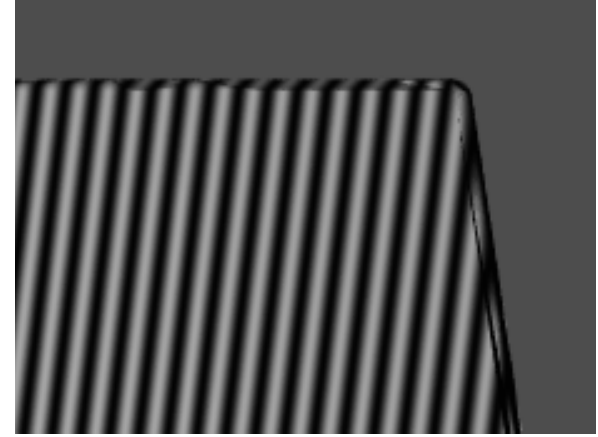
Figure 5. Render results without stripes